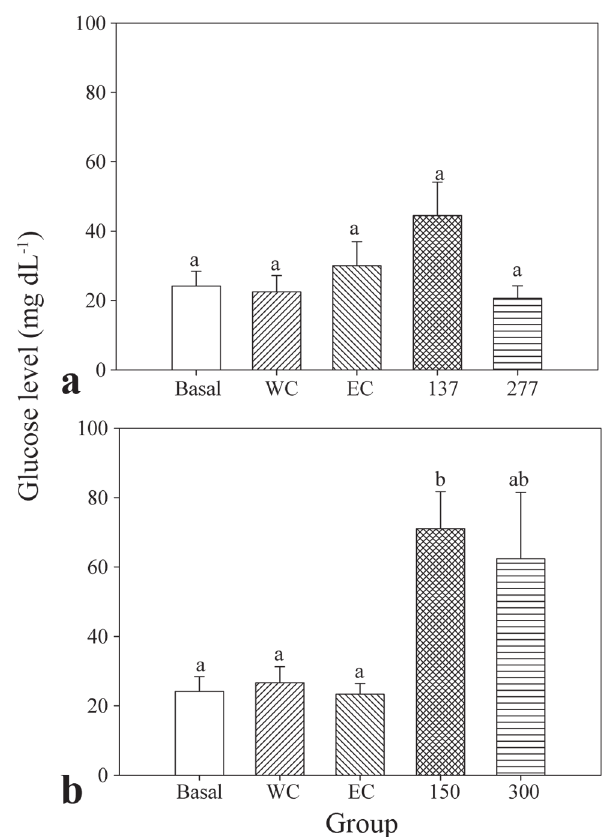
Fig. 3. Blood glucose levels after anesthesia of silver catfish with essential oils: A = essential oil of Hesperozygis ringens ; B = essential oil of Ocotea acutifolia ; W = water control; EC = ethanol control. Data are presented as mean±SEM (N = 6). Different letters indicate significant differences among groups